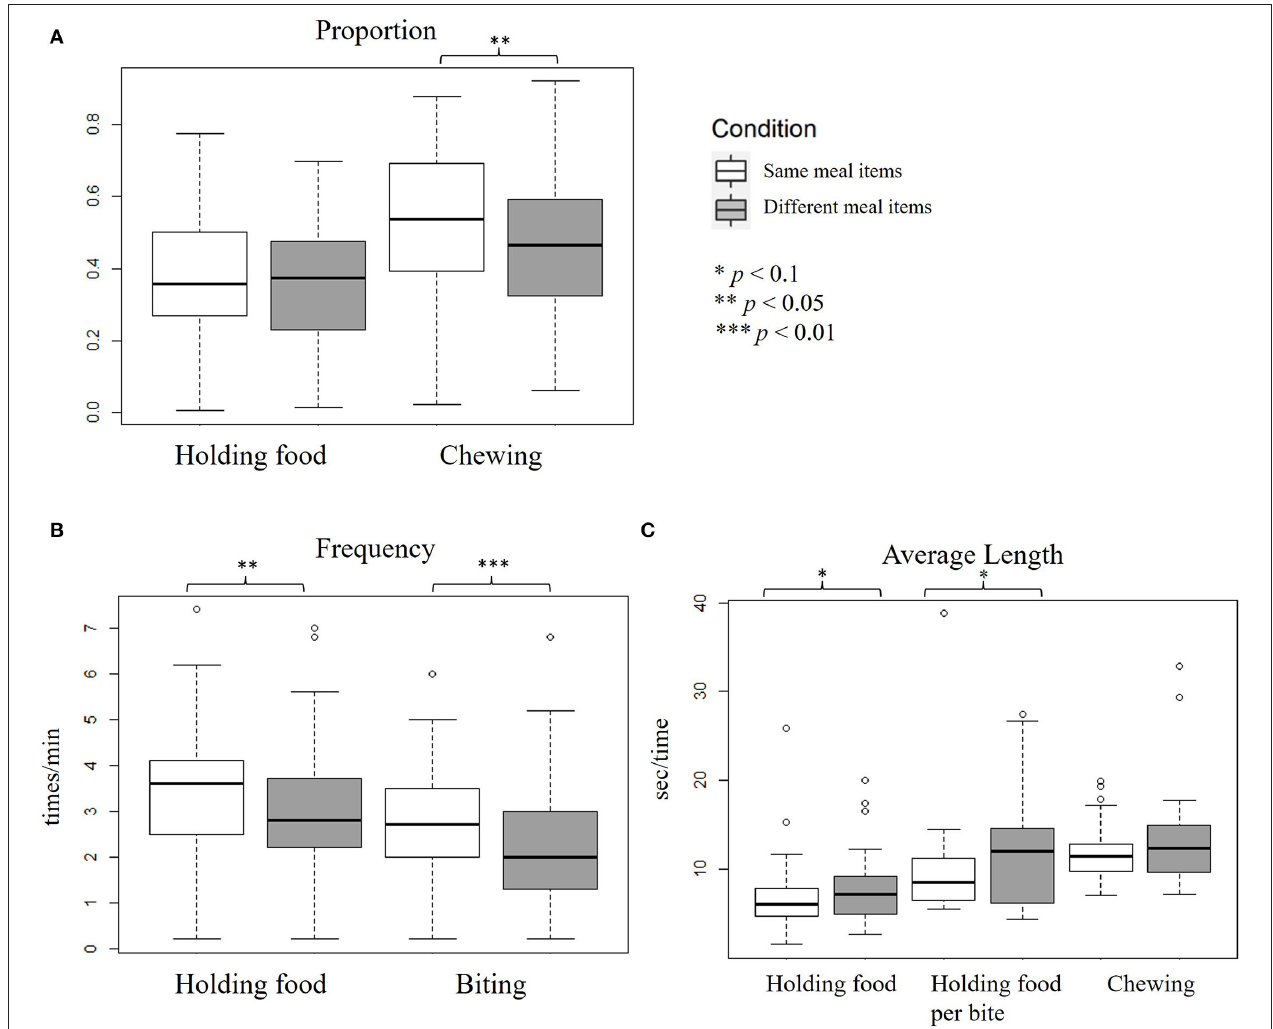
FIGURE 4 | (A) Proportions of holding food and chewing. (B) Frequencies of holding food and biting. (C) Average lengths of holding food, holding food per bite, and chewing.